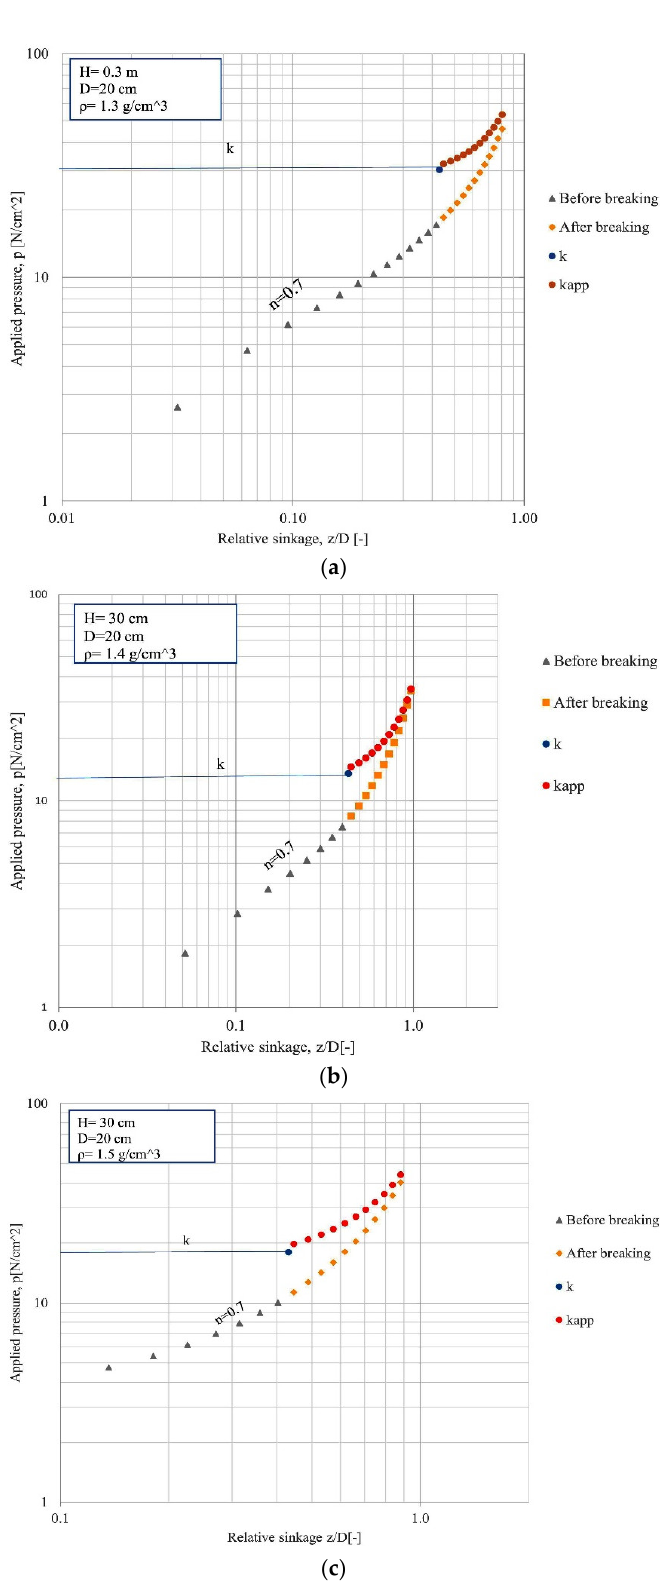
Figure 8. Pressure–sinkage curves with k app for a soil thickness level of 30 cm at bulk densities